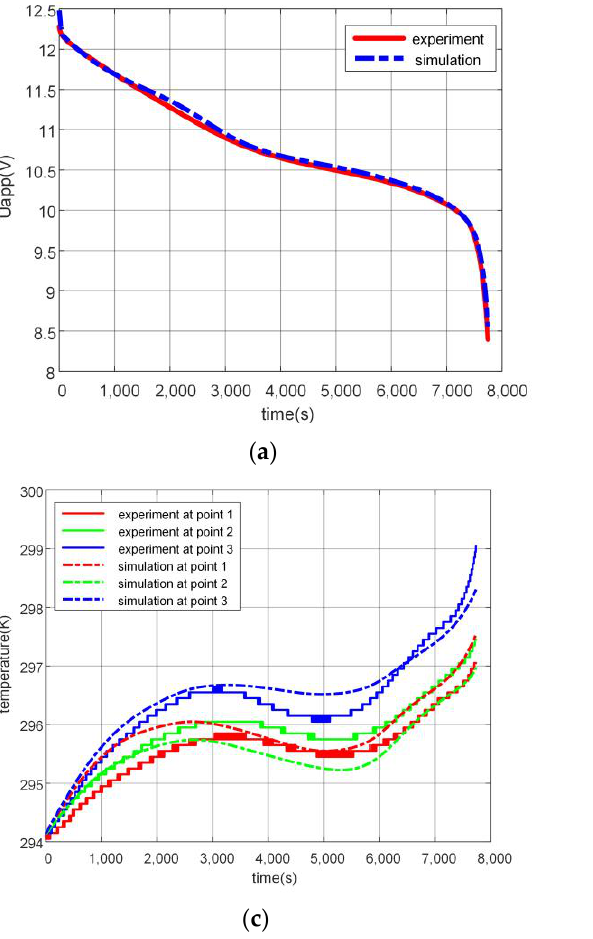
Figure 8. Battery pack and temperature acquisition point arrangement. The comparison of terminal voltage and temperature is shown in Figure 9. The mean absolute errors are shown in Table 5.